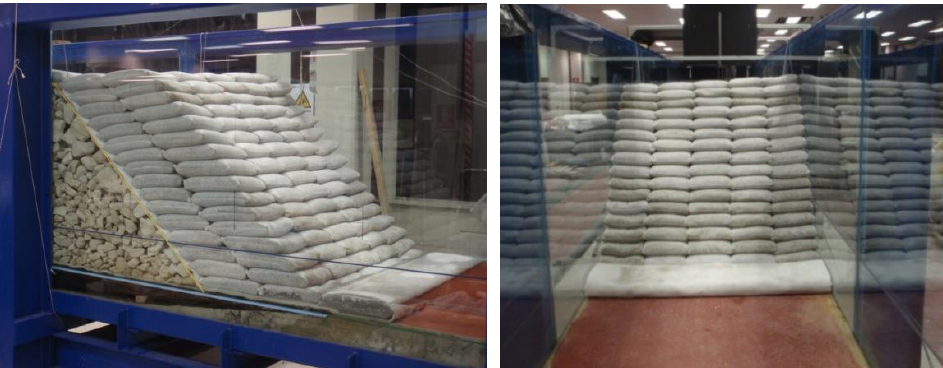
Figure 5. GSC revetment structure with a slope of 1:1 ( lateral and front views).